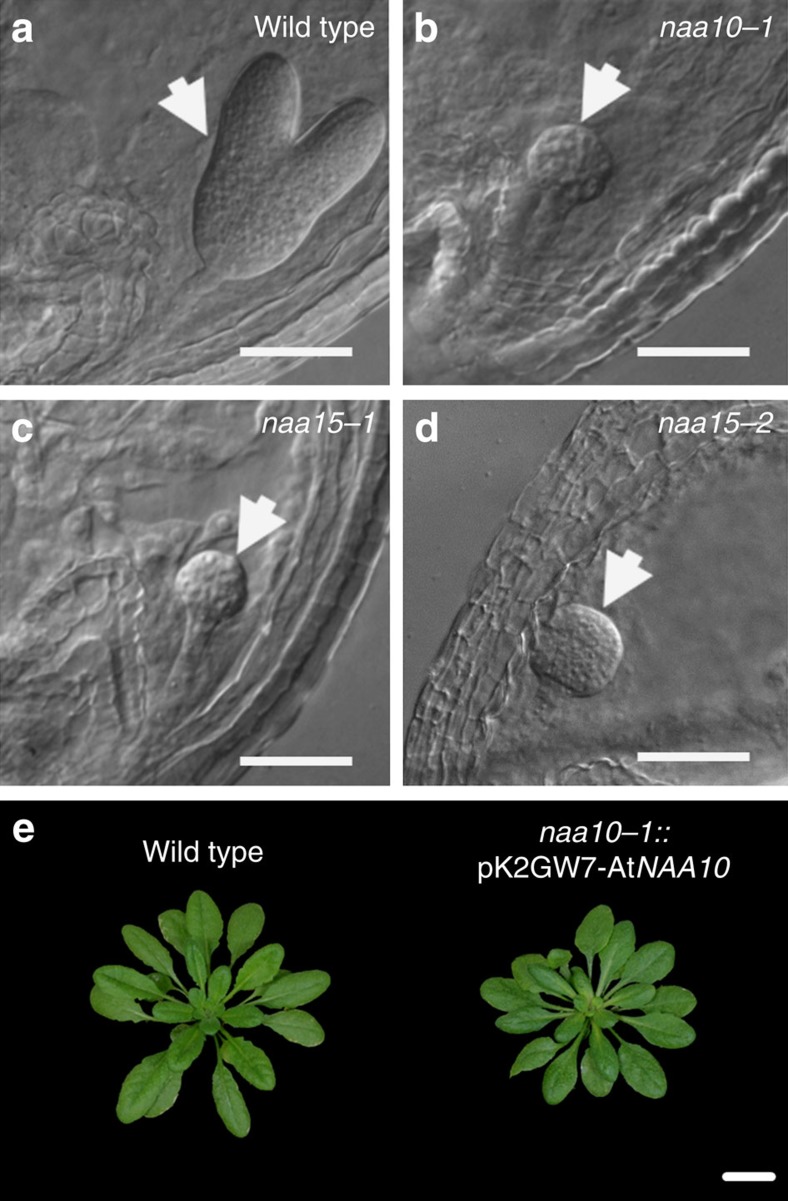
Loss of the NatA complex causes embryo lethality.(a–d) Differential interference contrast microscopy (DICM) of developing embryos (arrows) in wild-type (a), naa10-1 (b), naa15-1 (c) and naa15-2 (d) plants 14 days after flowering. Plants were grown and seed pods embedded for DICM as described in Supplementary Methods. (e) Phenotype of 8-week-old wild-type and homozygous naa10-1 plants that ectopically express AtNAA10 (pK2GW7-AtNAA10). Only one representative pK2GW7-AtNAA10 line out of five successfully complemented transgenic homozygous naa10-1 lines is shown. Scale bar, 0.1 mm (a–d) or 2 cm (e).